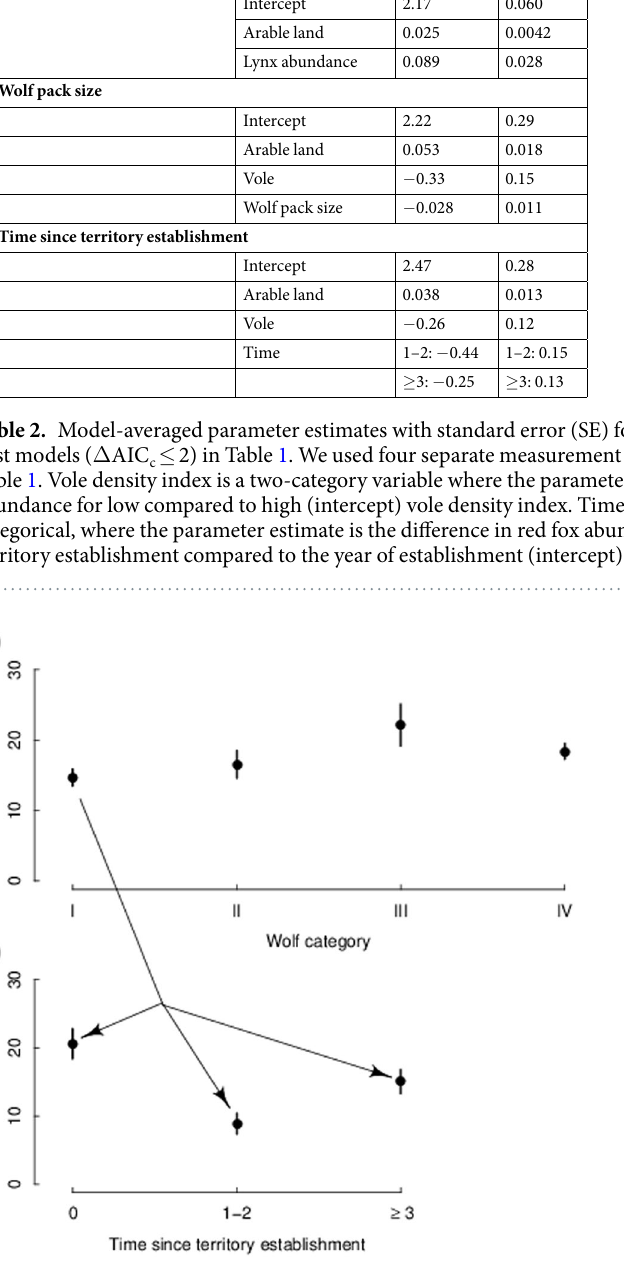
Figure 2. Upper panel ( a ) shows mean ( ± SE) red fox abundance (crossings 10 km − 1 24 h − 1 ) in relation to a 4-level wolf category: (I) inside an observed wolf territory, (II) inside an average wolf territory, (III) inside a maximum wolf territory, and (IV) outside a wolf territory. Lower panel ( b ) shows mean ( ± SE) red fox abundance from wildlife triangles located inside estimated wolf territory borders (i.e., wolf category I) in relation to time since territory establishment (years) where year 0 is the year of territory establishment by a wolf pair. Red fox abundance was surveyed by snow-tracking in wildlife triangles in south-central Sweden from